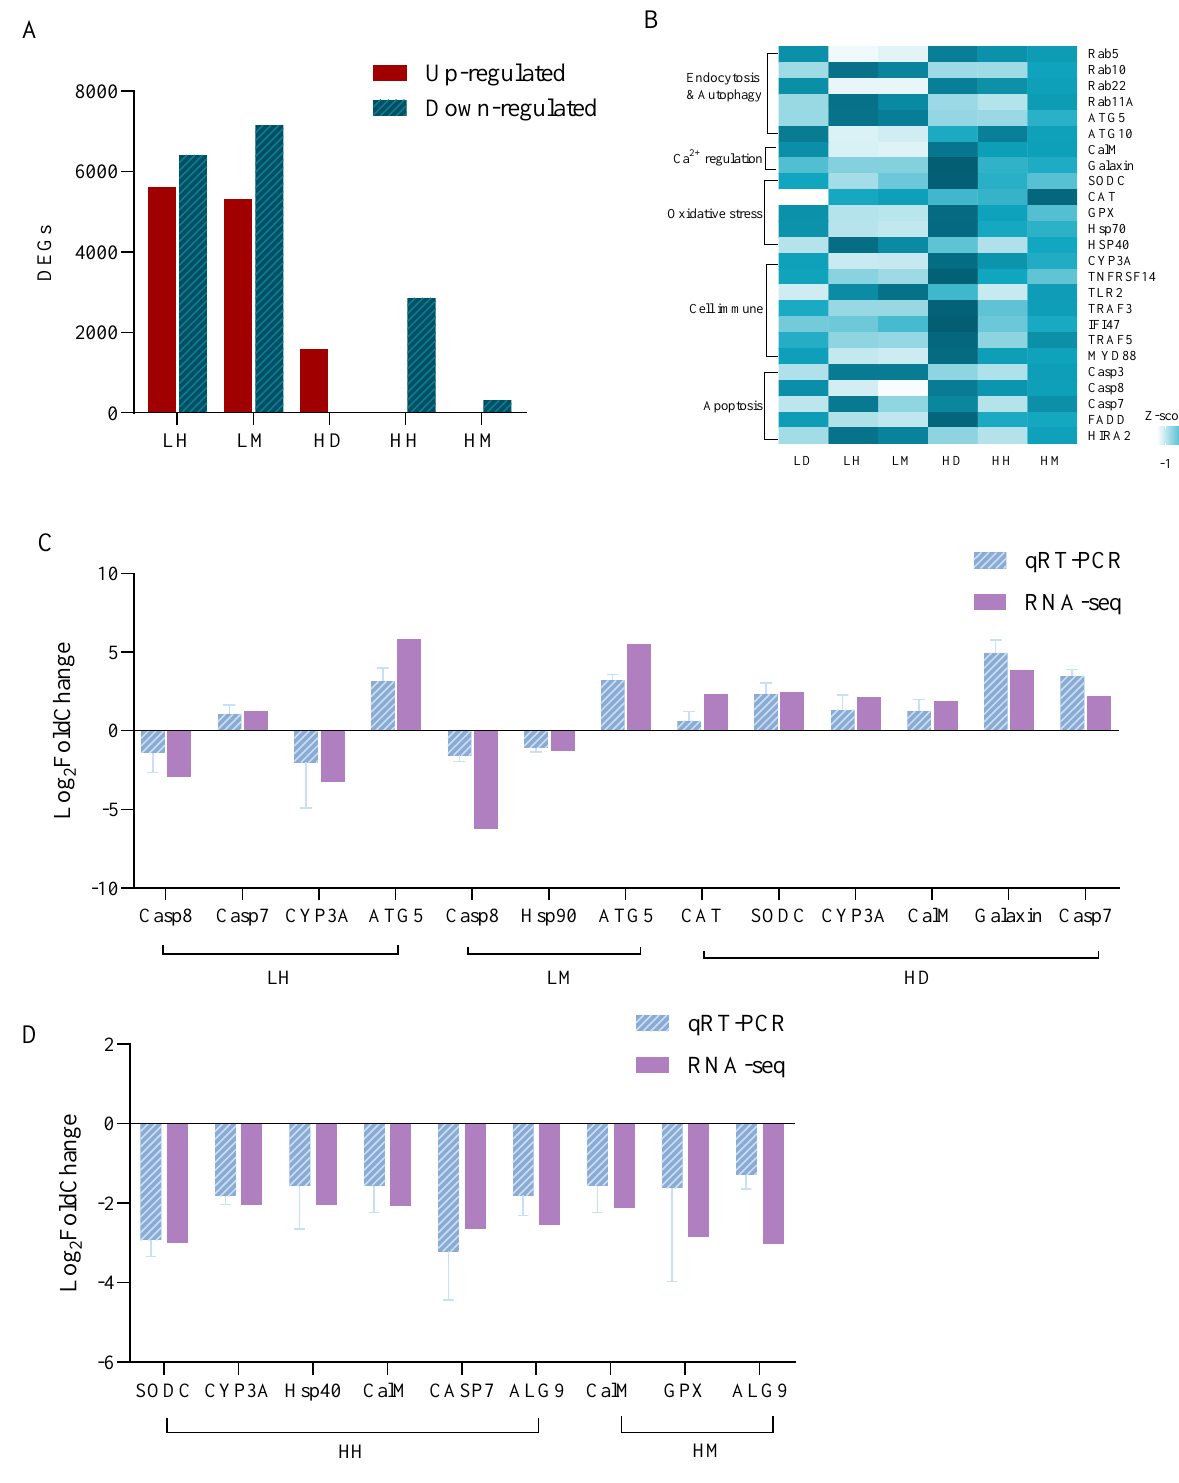
Figure 3. Gene expression dynamics of A. hyacinthus after 4 weeks of the experiment. ( A ) DEGs statistics in all treatments. Select FDR < 0.001 and shown as LH, LM, and HD groups vs. LD group, HH and HM groups vs. HD group. ( B ) FPKM expression map of different biological processes regulated by DEGs. ( C ) Compared with the LD group, the DEGs verification of LH, LM, and HD groups. ( D ) Compared with the HD group, the DEGs verification of HH and HM. The source data are provided as a source data file in Tables S6 – S8.